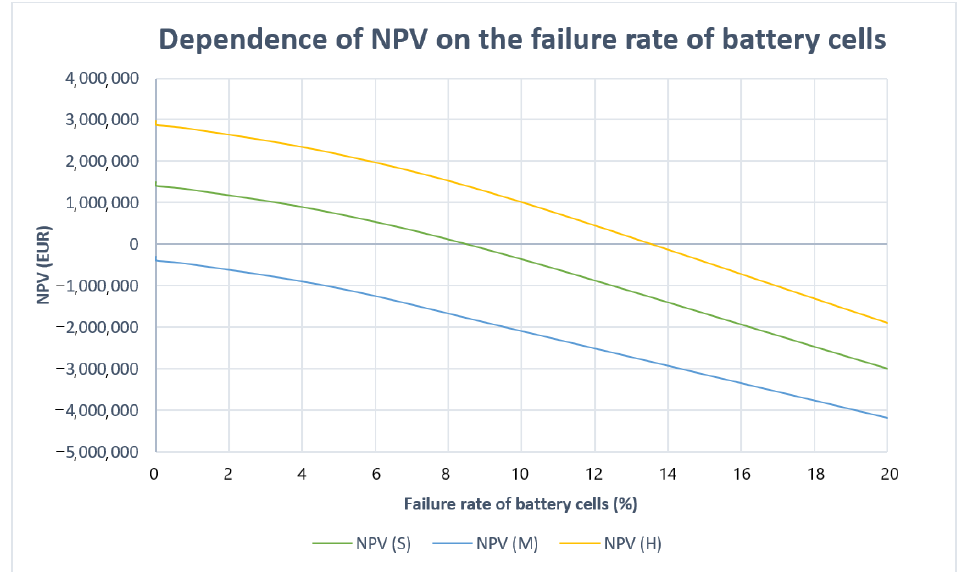
Figure 8. Dependence of NPV on the failure rate of battery cells of the large battery storage strat- egy.